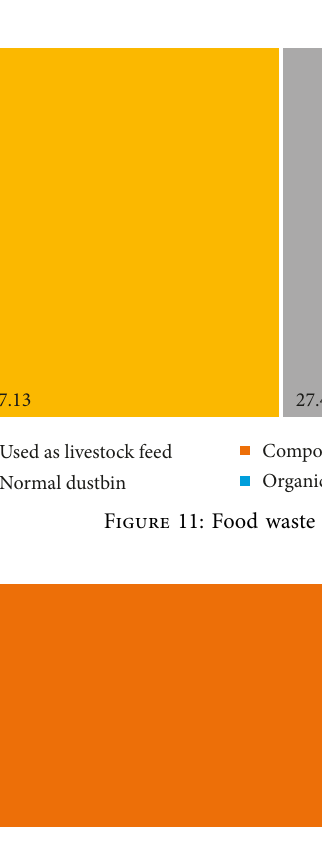
Figure 10: Effective ways to reduce food waste believed by respondents.